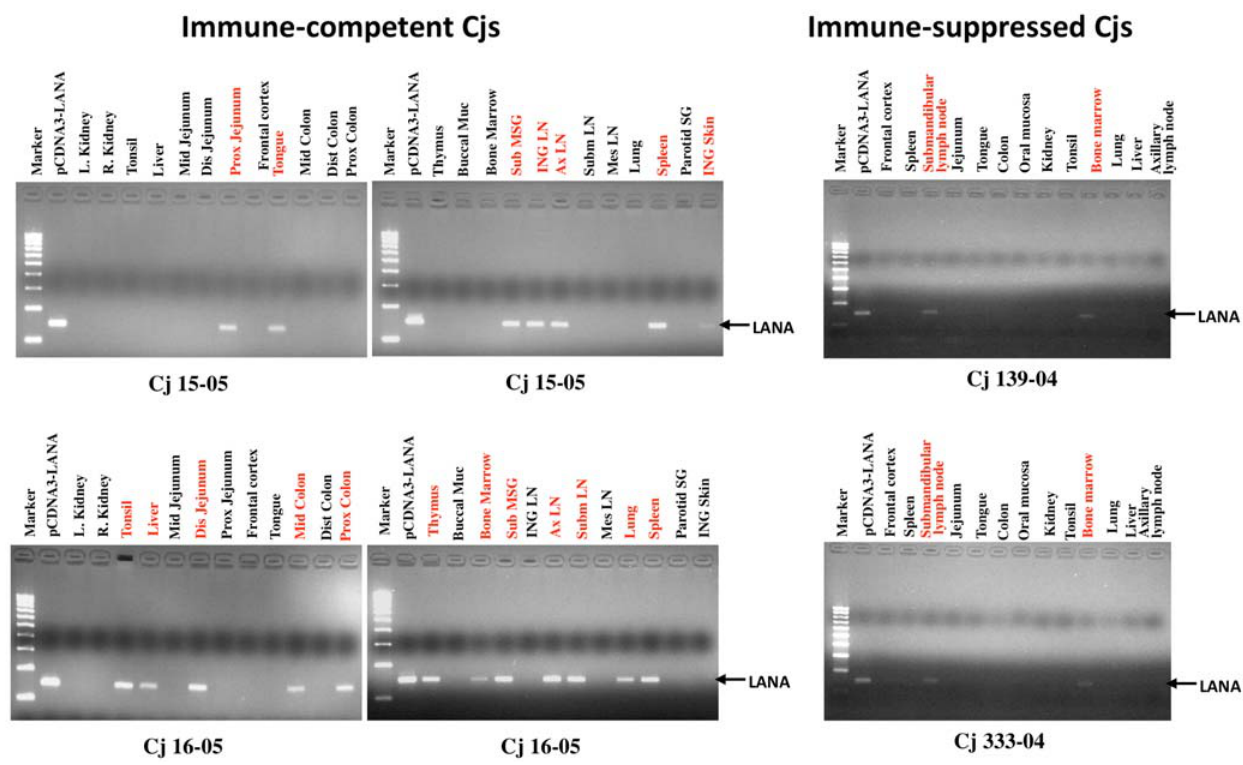
Figure 5. Tissue distribution of viral LANA DNA in rKSHV.219-infected common marmosets. Genomic DNA purified from tissue samples of immune-competent Cj15-05 and Cj16-05 and FK506-treated Cj333-04 and Cj139-04 were used for real-time PCR with LANA-specific primers. Mid, middle; Dis, distal; Prox, proximal; Buccal Muc, buccal mucosa; SubMSG, submandibular salivary gland; ING LN, inguinal lymph node; AxLN, auxiliary lymph node; SubmLN, submandibular lymph node; MesLN, mesenteric lymph node; Parotid SG, parotid salivary gland; ING Skin, inguinal skin. Marker, 100-bp DNA molecular markers. The results show the averages of two repeats and standard deviations.